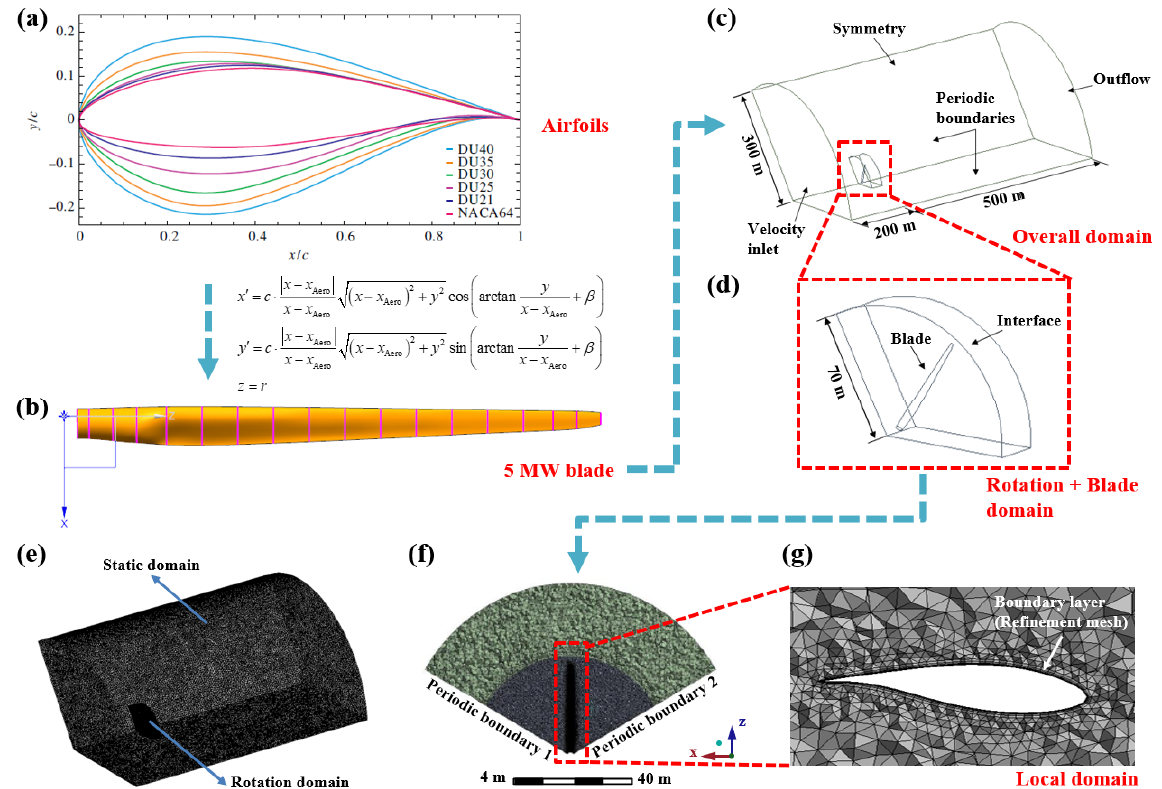
Figure 1. Establishment of 5 MW wind turbine blade. ( a ) Normalized section data of airfoils. ( b ) Wind turbine blade. ( c ) Geometric overall domain. ( d ) Geometric rotation and blade domains. ( e , f ) Stereogram and side view of fluent mesh models. ( g ) Local fluent mesh view of blade.